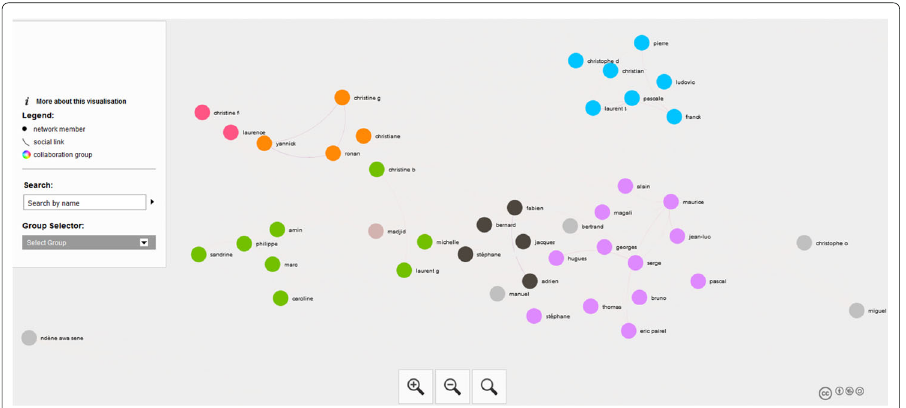
Fig. 7 Community Network processed with spatial layout algorithms (HTML